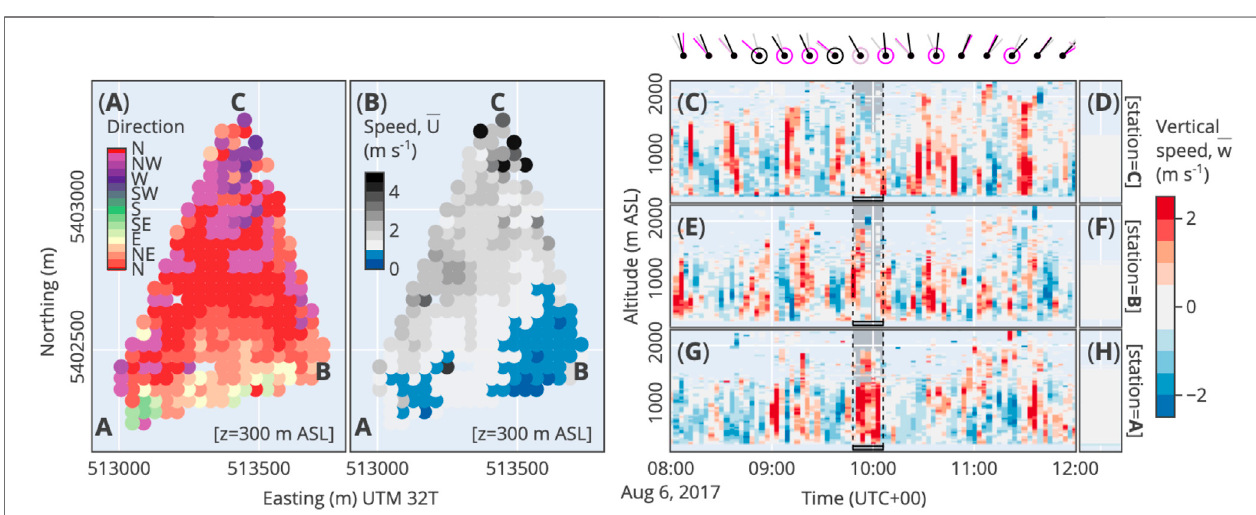
FIGURE 12| ShownforlocationsinStuttgartCityCentreareatopviewofthe (A) meanwinddirectionand (B) meanwindspeedforthehighlightedperiodsintheright panels,and (C,E,G) theverticalwindspeedagainsttimeandaltitudeaboveDLstationlocations “ A ” , “ B ” and “ C ” ,and (D)(F)(H) themeanverticalwindspeedbetween08:00 and12:00UTCon06August2017.Windbarbsshownontoprepresentthe15-minmeandirectionat340m,530and720ma.s.l.,inmagenta,greyandblack,respectively.